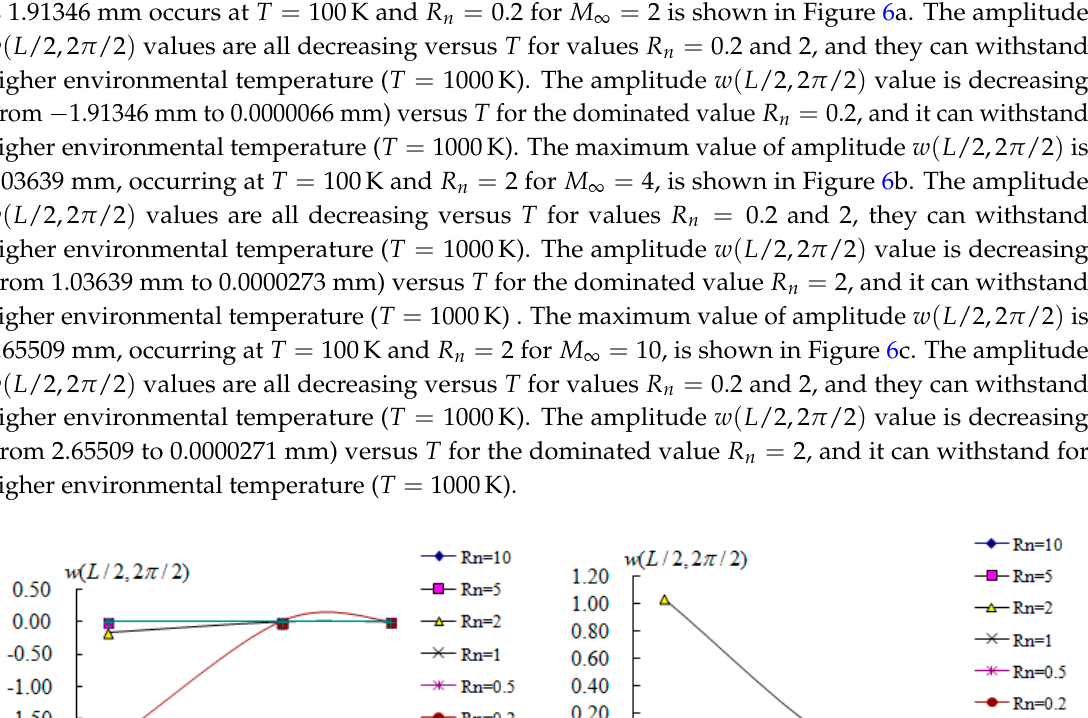
Figure 6. (mm) versus T ( K ) and